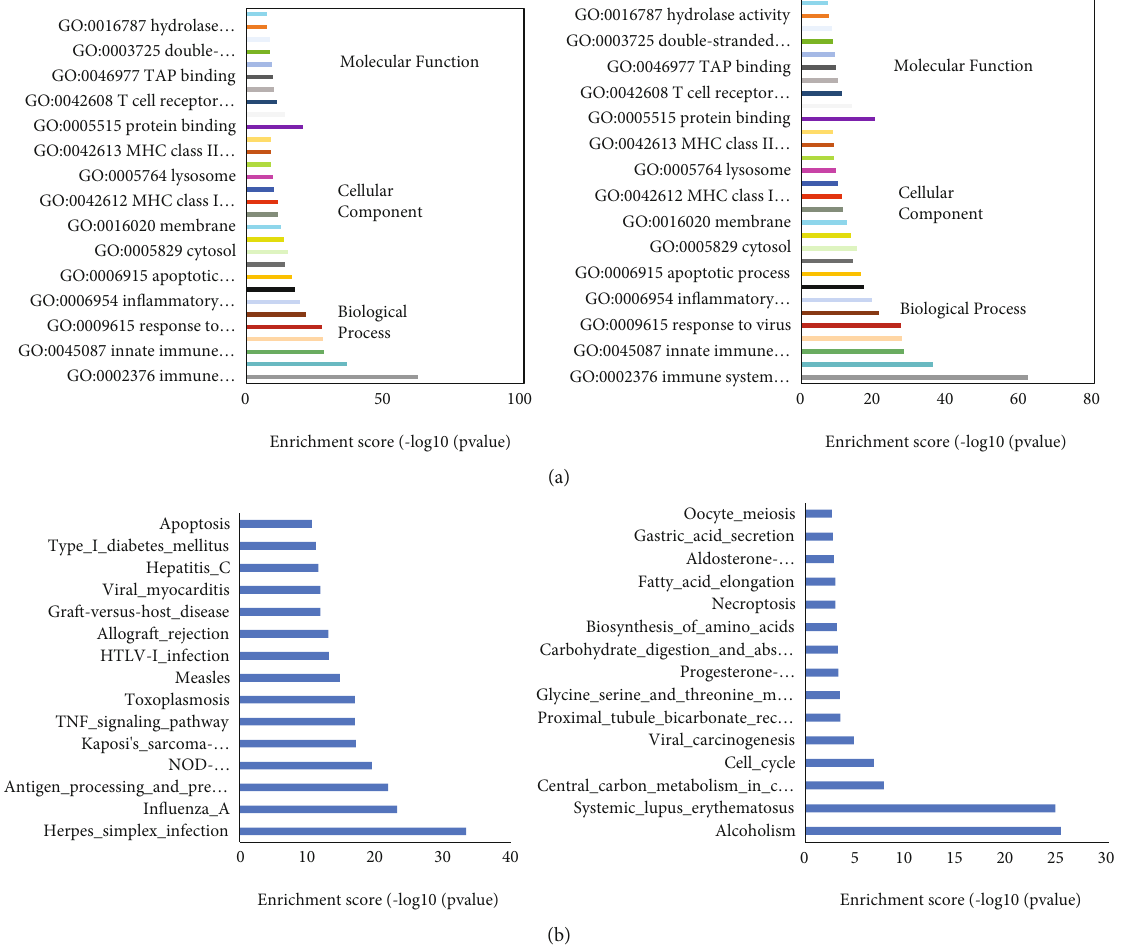
Figure 2: GO terms and KEGG pathway enrichment analysis of upregulated and downregulated mRNAs. (a) Top 10 biological processes, cellular component, and molecular function of GO terms for the analysis of upregulated (left) and downregulated (right) mRNAs. (b) Top 15 KEGG pathways for analysis of upregulated (left) and downregulated (right)